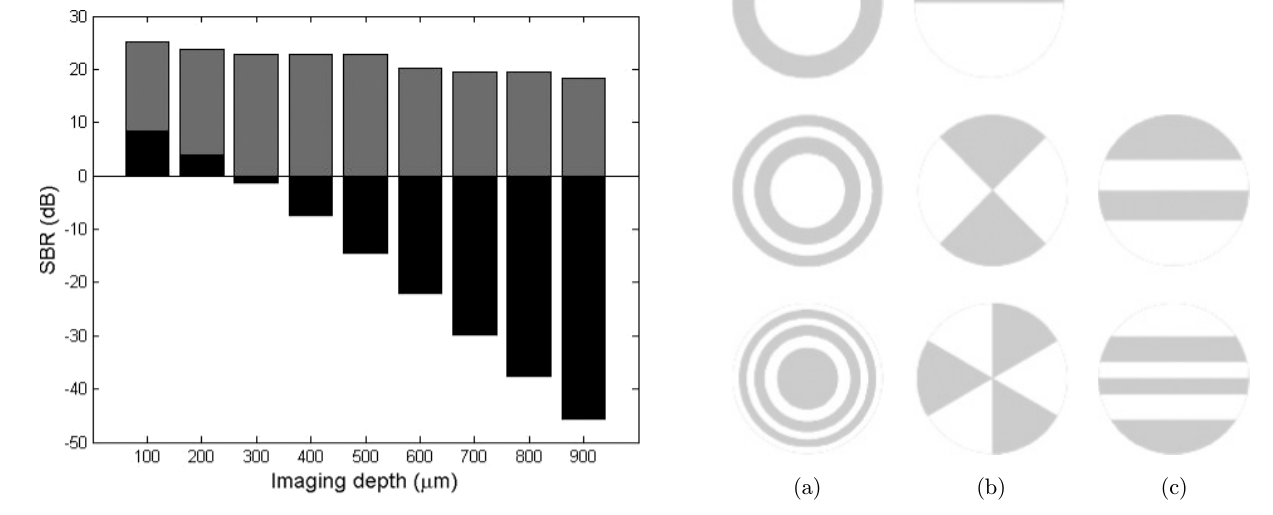
Fig. 6. SBR of FMM (circles) and CM (asterisks) as a function of imaging depth.